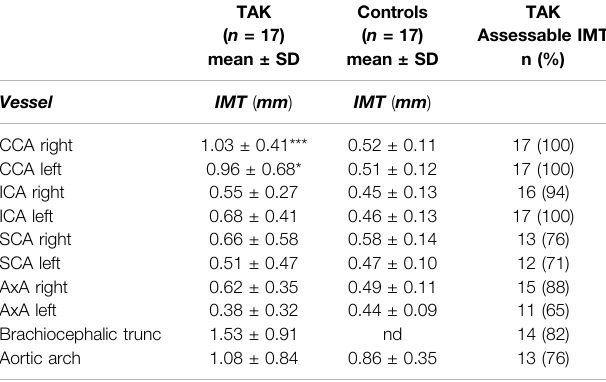
TABLE 2 | Assessable arteries refers to arteries without occlusion or signi fi cant stenosis. Intima-media thickness (IMT), in measured areas. TAK, Takayasu arteritis; mm, millimeter; CCA, common carotid artery; ICA, internal carotid artery; SCA, subclavian artery; AxA, axillary artery; nd, not done; n, number of